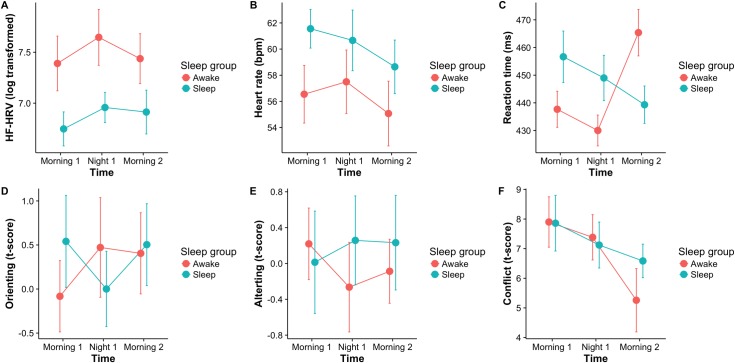
Main effects and interactions of group and measurement period on heart rate variability, heart rate, and ANT measures.Line graphs illustrate means and 95% confidence intervals for log-transformed HF-HRV (1A), HR (1B), mean reaction time (1C), Orienting t-values (1D), Alerting t-values (1E), and Conflict t-values (1F). Error bars represent 95% confidence intervals, which are corrected to remove between-subject variability. M1 = Morning 1; N1 = Night 1, M2 = Morning 2.